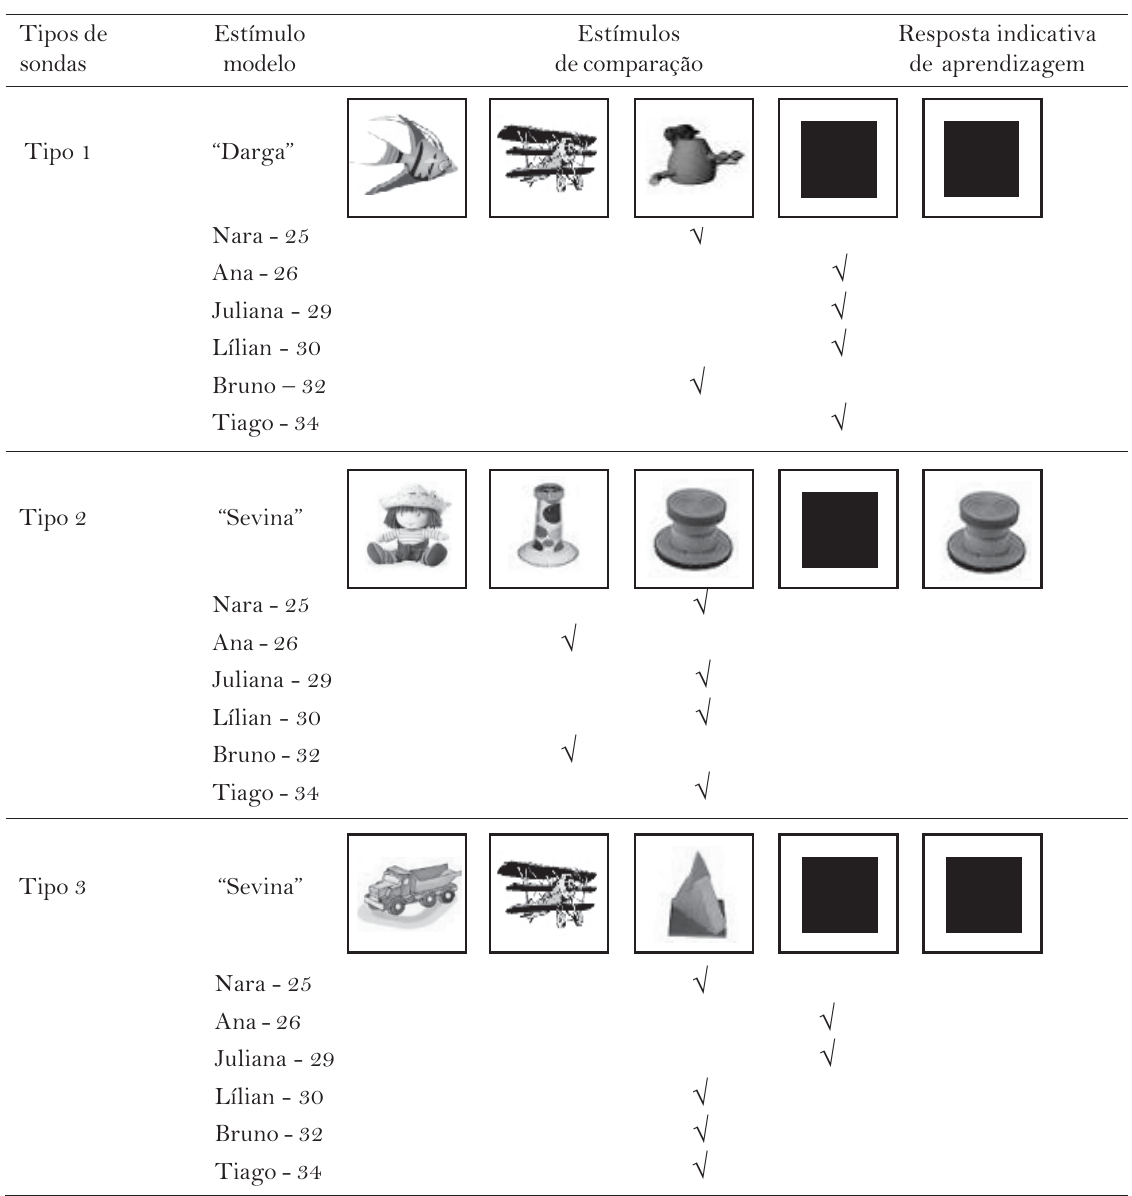
Seleções de cada Participante ( √ ) na Segunda Tentativa de Verificação de Aprendizagem em cada Tipo de Sonda. Os Dígitos ao Lado do Nome Fictício de cada Participante Indicam sua Idade em